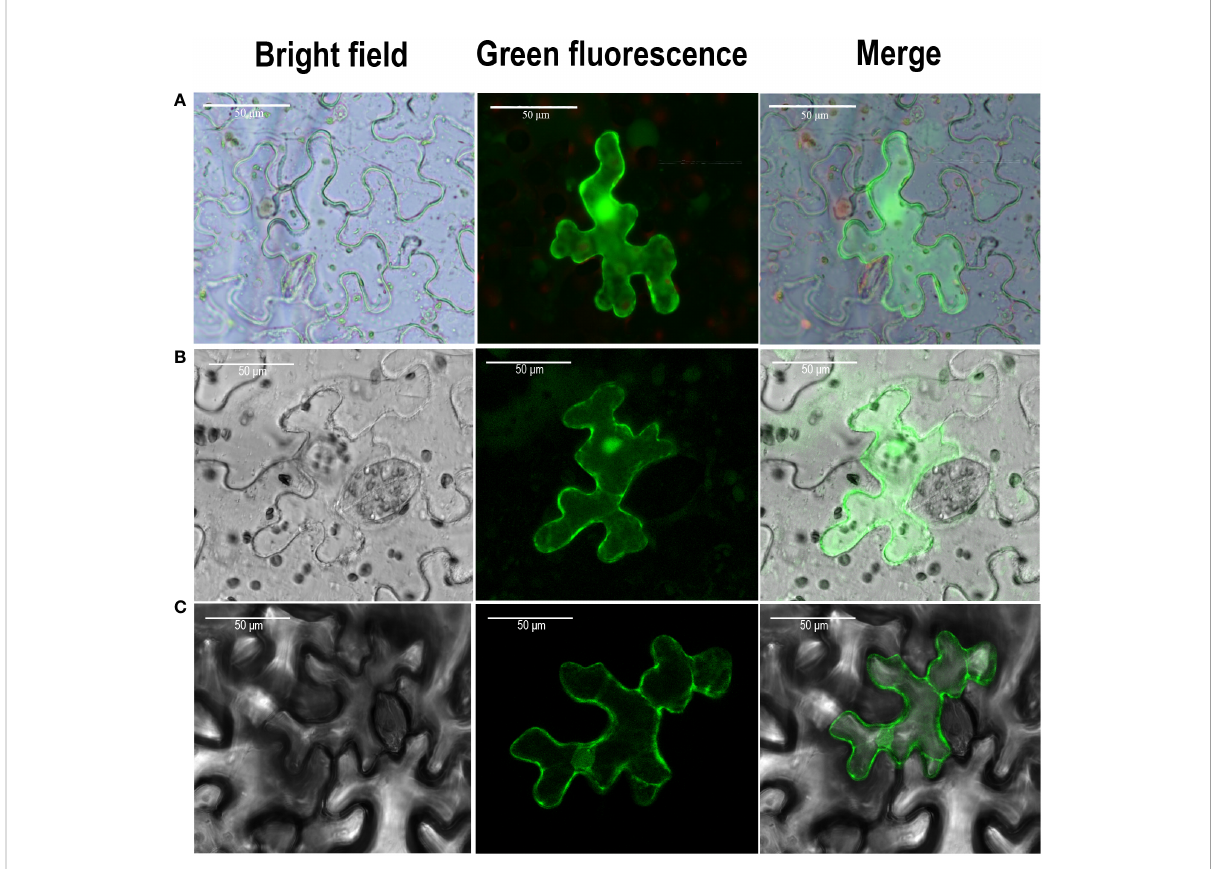
FIGURE 8 Subcellular localization of TaPAL genes. (A) Subcellular localization offree GFP. (B) Subcellular localization of TaPAL32. (C) Subcellular localization of TaPAL42. Subcellular localization was then observed by confocal laser scanning microscopy 48 – 72 h after in fi ltration. Scale bar = 50 m